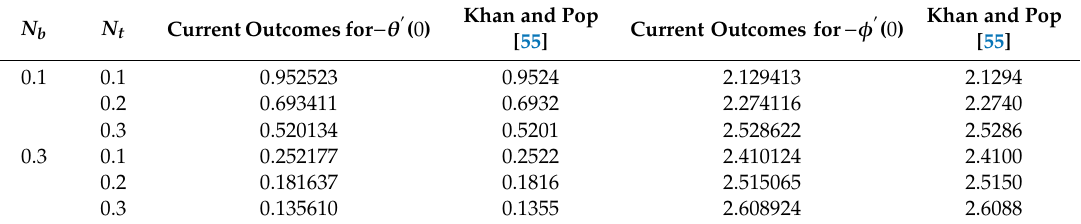
= N r = R = 0, E c = σ = δ = E = 0. 1 b R 2 e